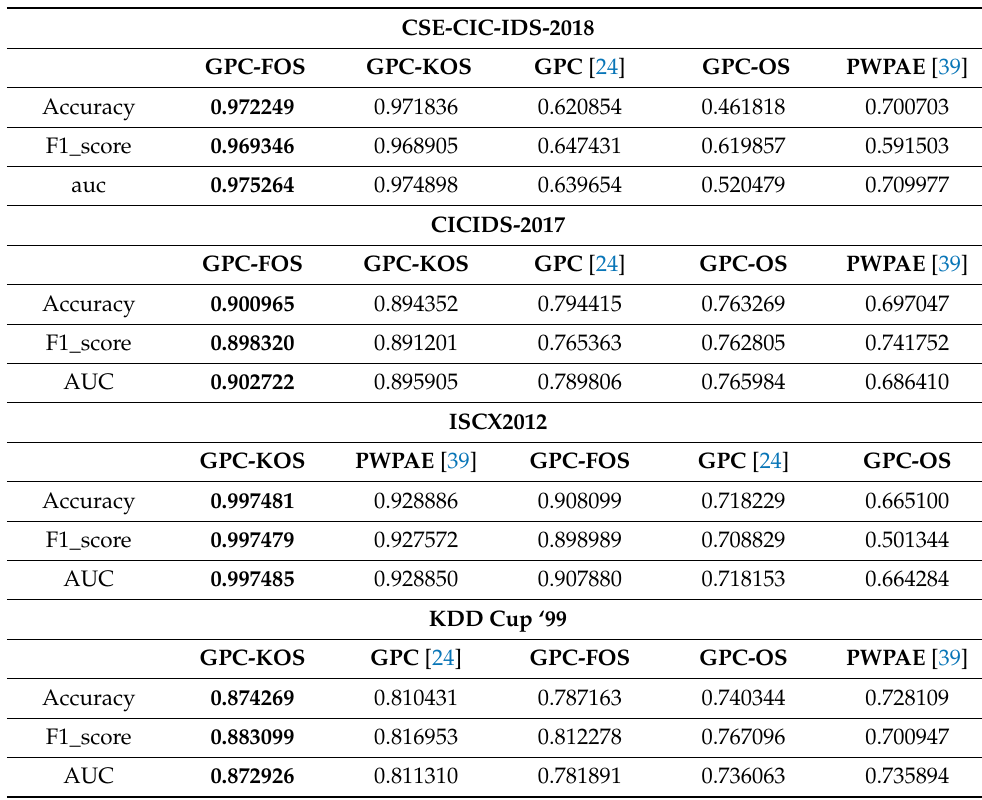
Table 7. Summary of numerical values of accuracy, F1-score, and AUC for GPC variants (OS, FOS, KOS) and benchmarks for real-world